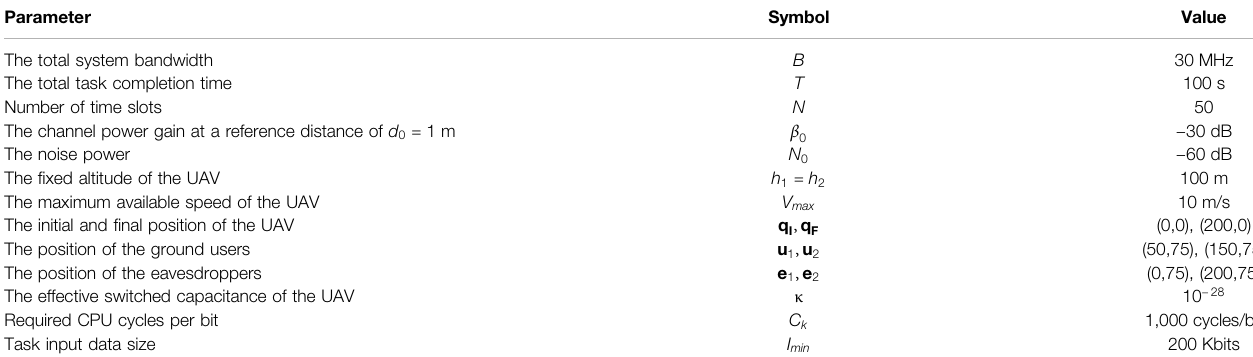
TABLE 1 | Simulation parameters.